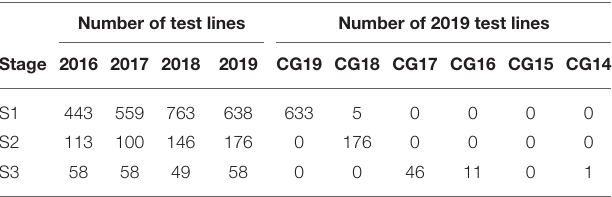
TABLE 9 | Number of test lines in each stage (S1 to S3) and year (2016-2019) in the chickpea breeding program.